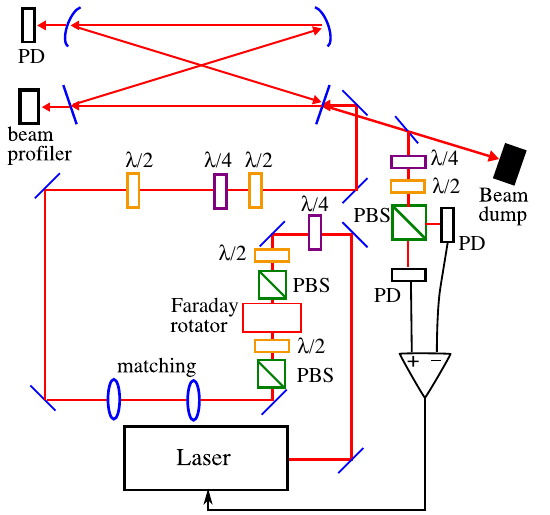
FIG. 13. Setup of the optical system. λ = 2 : half-wave plate, λ = 4 : quarter-wave plate, PBS: polarizing beam splitter, PD: photo- diode, isolator consists of Faraday rotator and PBS.